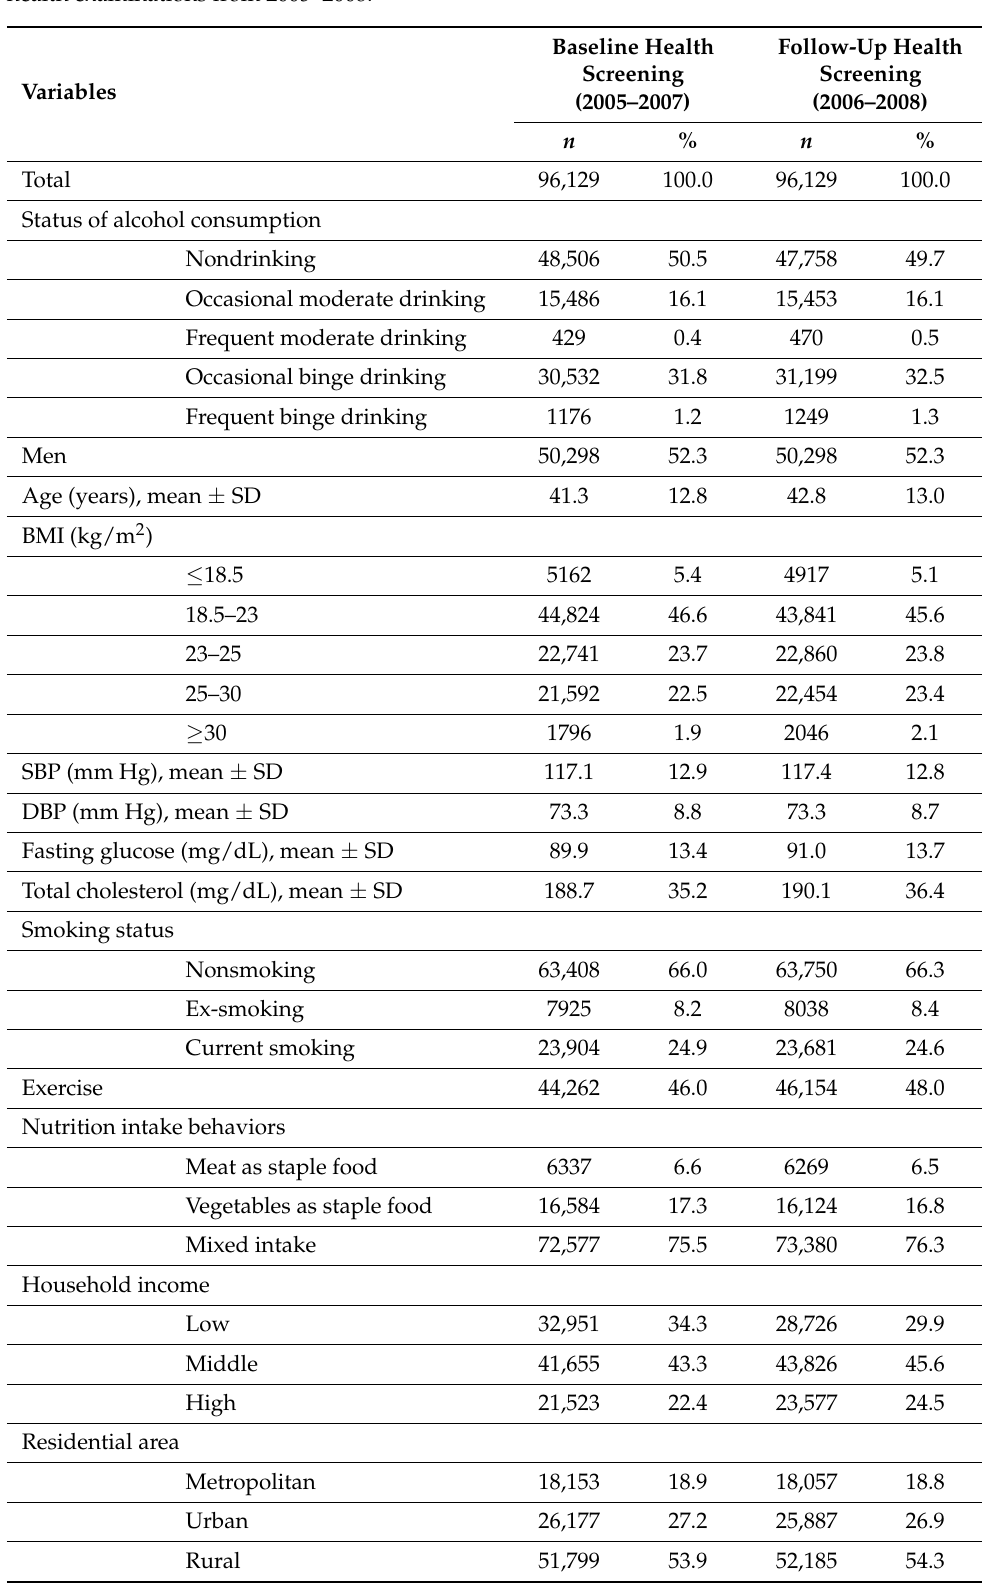
Table 1. General characteristics of study participants who received 2 consecutive biennial national health examinations from